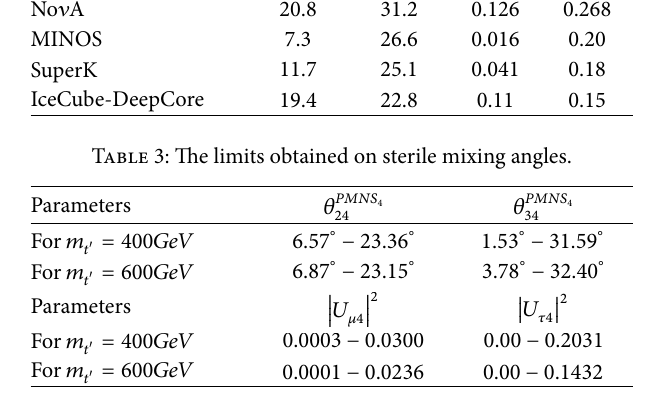
Table 1: Numerical values of all the parameters used in 𝑈 trix [32–34]. Parameters 𝐶𝐾𝑀 4